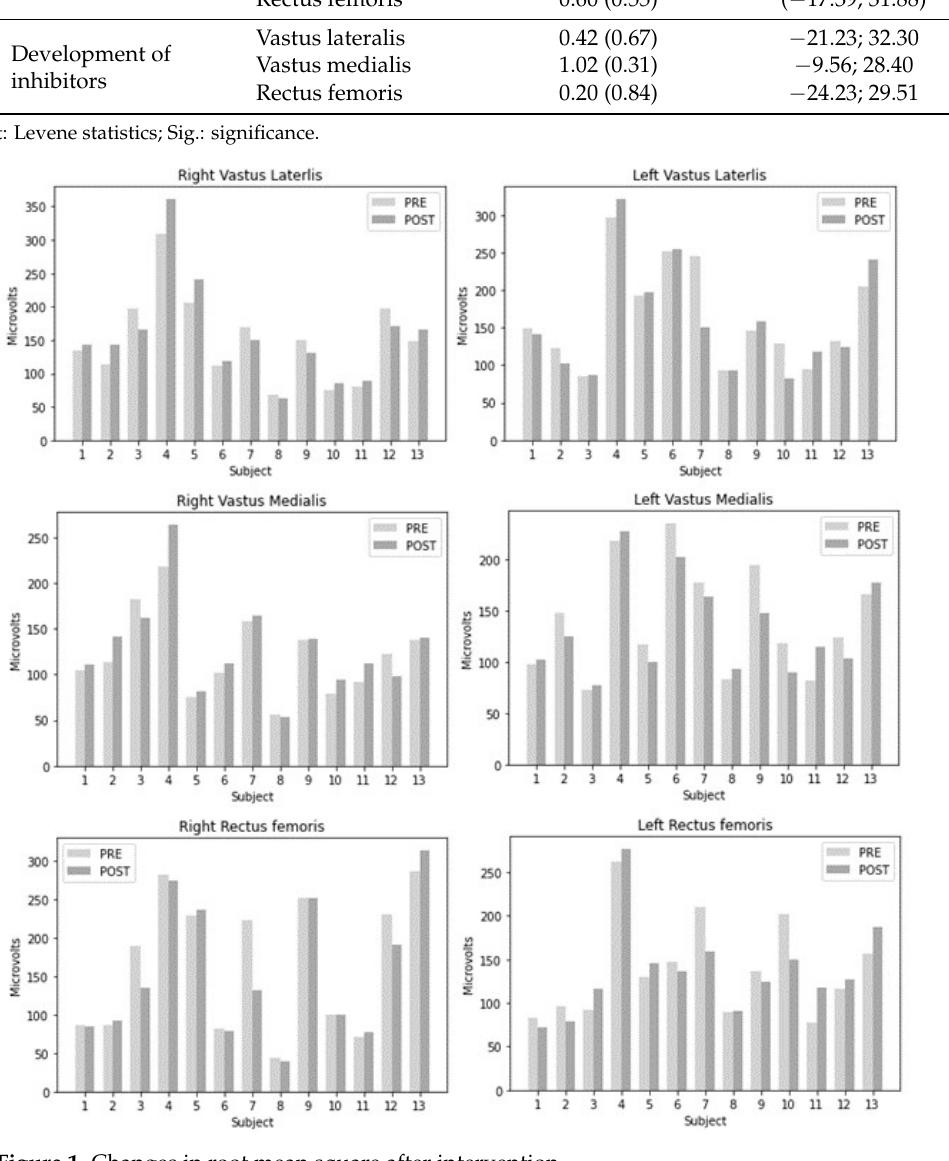
Table 5. Correlation between the observed difference in means and quantitative variables. Muscle